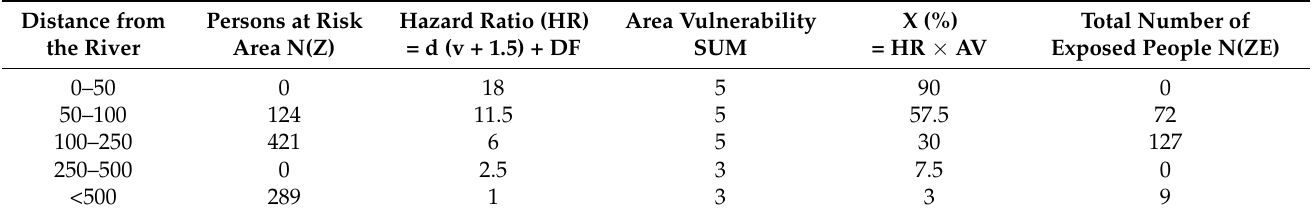
Table 4. Calculation of the number of people exposed to flood risk.